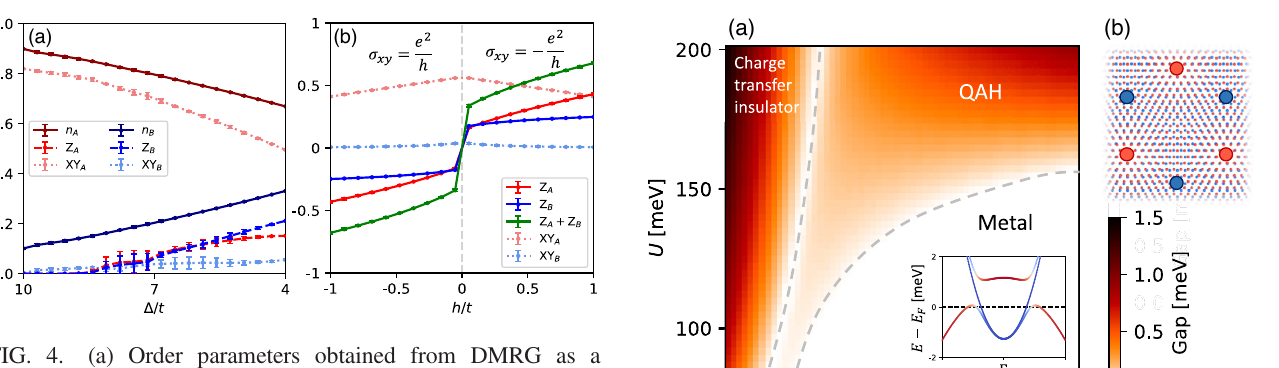
FIG. 4. (a) Order parameters obtained from DMRG as a function of Δ , showing qualitatively similar results as the self- ≠ 0 is likely due to consistent HF Hamiltonian. The small XY B the cylindrical geometry (Appendix A). (b) Response to an applied Zeeman field h . There is a discontinuity at h ¼ 0 due to FIG. 5. (a) HF phase diagram using the realistic model param- broken symmetry. While Z is quickly saturated, Z continues to B A 4 . 5 ; 9 ; 2 Þ meV (Appendix B) describing ; t ; t eters ð t increase with h while XY decreases, indicating a smooth A B AB Þ ¼ ð A holes in MoTe 2 = WSe 2 . Color indicates the charge gap. We find variation in the canting. The Hall conductivity σ changes sign xy Mott, QAH, and metal phases near band inversion. The inset shows discontinuously at h ¼ 0 . Hysteresis is absent as we obtain the the quasiparticle bands near the Fermi energy in the metal phase at ground state independently for each value of h . Δ ¼ 65 meV and U ¼ 100 meV. Note that our tight-binding model describes holes in this system; hence, these bands are minus the electron bands. (b) Illustration of the moir´e superlattice in MoTe 2 = WSe 2 . Low-energy hole states on the MoTe 2 layer are localized on the MM (red), and WSe 2 on the XX (blue) regions. Together, they form an effective honeycomb